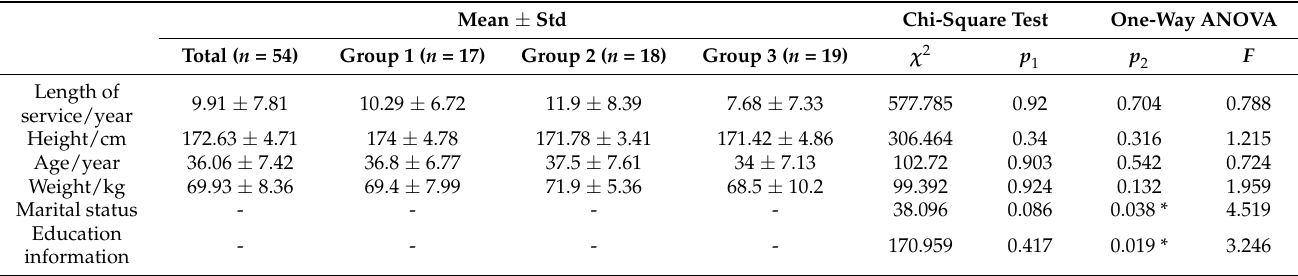
Table 1. The demographic information of 54 coal mine